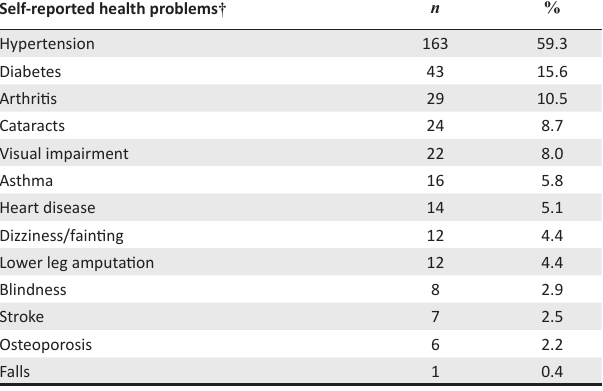
TABLE 3: Self-reported health problems of members of service centers ( n = 275).